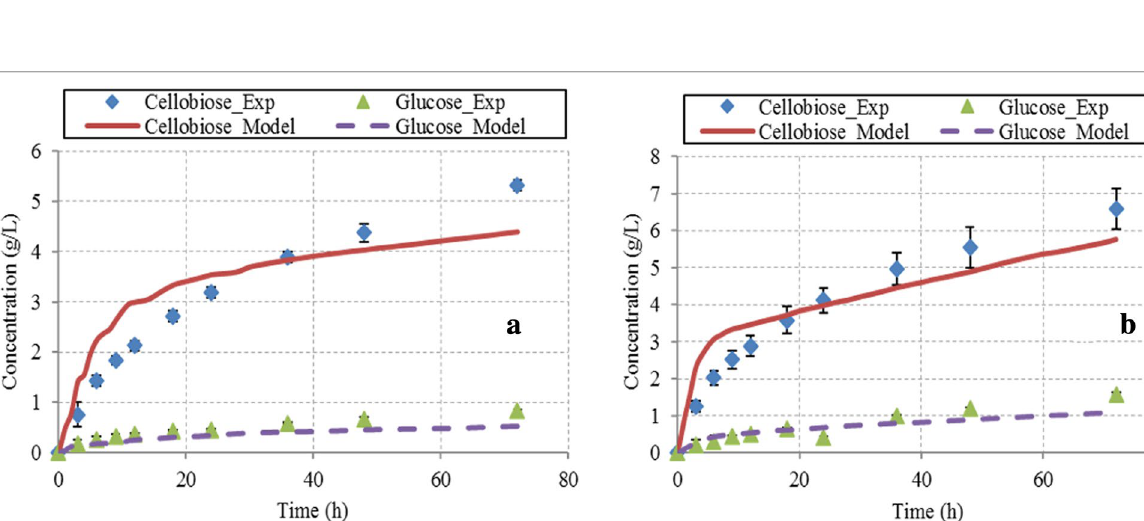
Fig. 10 Comparison of model simulations (solid lines) with experimental data during hydrolysis of filter paper (25 g/L) at CBH II loading of 10 mg/g cellulose: a sugar production, b rate of conversion of cellulose